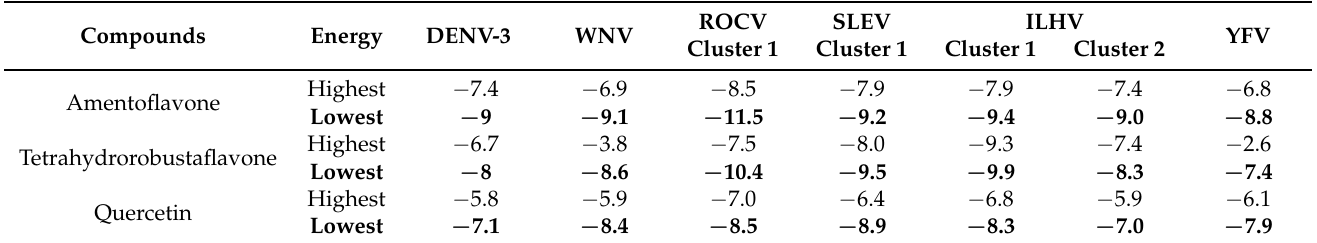
Figure 3. Delimitation of the box (grid) for the anchorage. The proteins on the left and right are on a ribbon and a surface, respectively. Yellow and lilac represent the two binding modes of amentoflavone at the allosteric site. Table 5. Vina score (energy in kcal/mol) of each ligand after molecular docking.